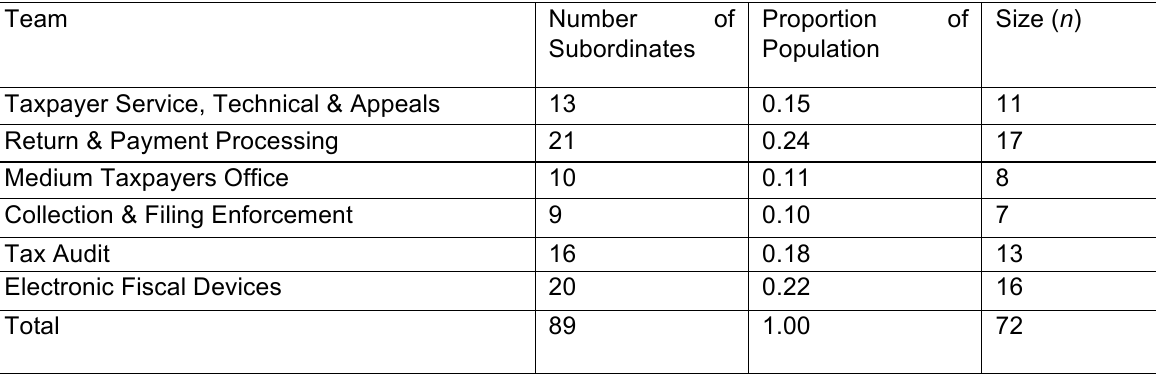
Table 1: Stratified sampling of survey participants ( N